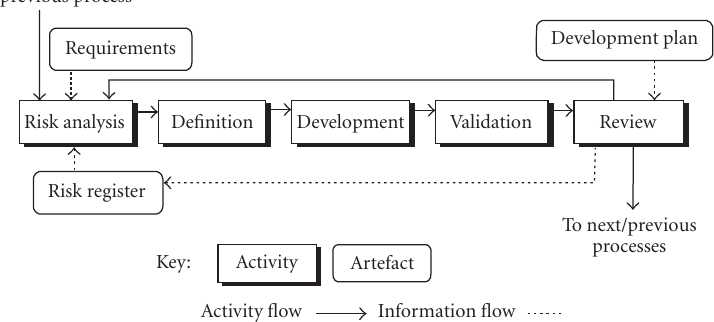
Figure 2: Abstract iterative process.